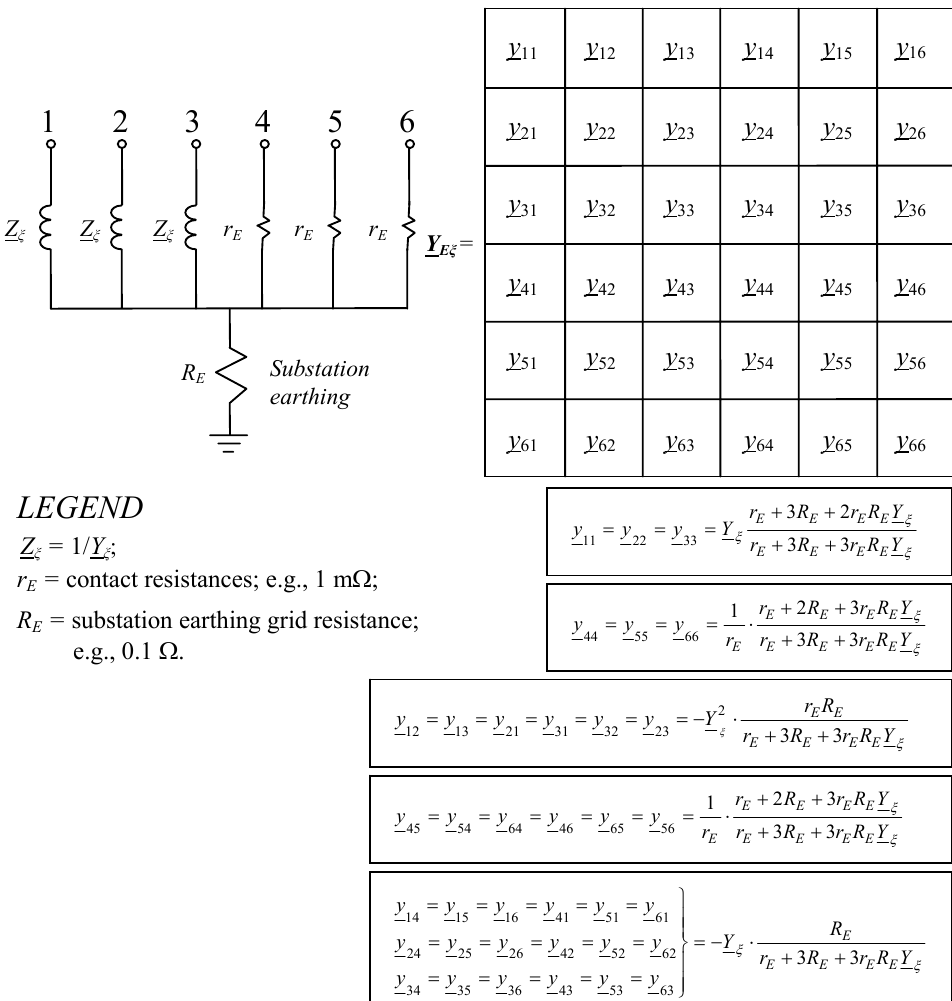
Figure 6. Admittance matrix Y